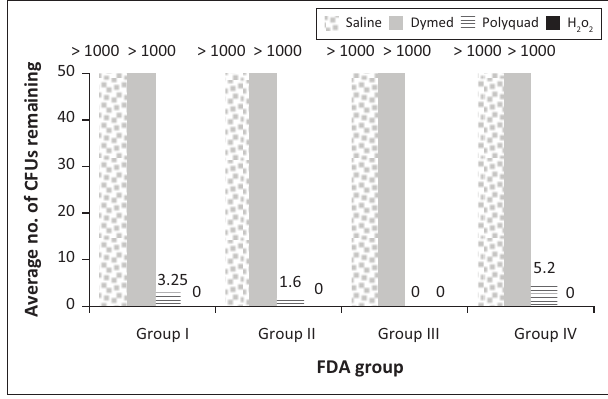
FIGURE 1: Solution effectiveness on the different Food and Drug Administration groups in removing Pseudomonas aeruginosa.